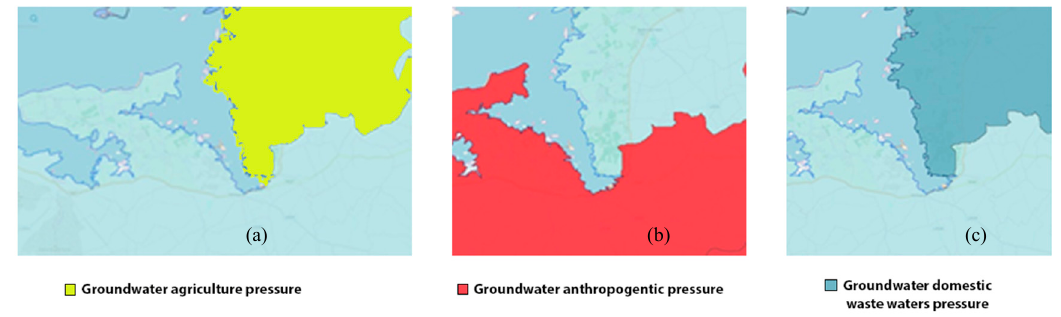
Figure 5. Some examples of groundwater pressures: ( a ) pressure from agriculture sources; ( b ) pressure from anthropogenic sources; ( c ) pressure from domestic wastewater sources (adapted from EPA).